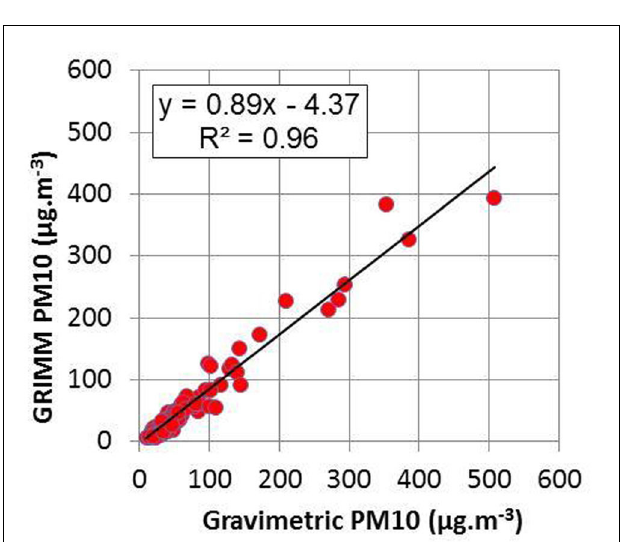
FIGURE 4 | Comparison between PM 10 concentrations measured in parallel with the GRIMM, after RI recalibration, and with the gravimetric method. The best fit regression line and the respective equation and correlation coefficient are given in the